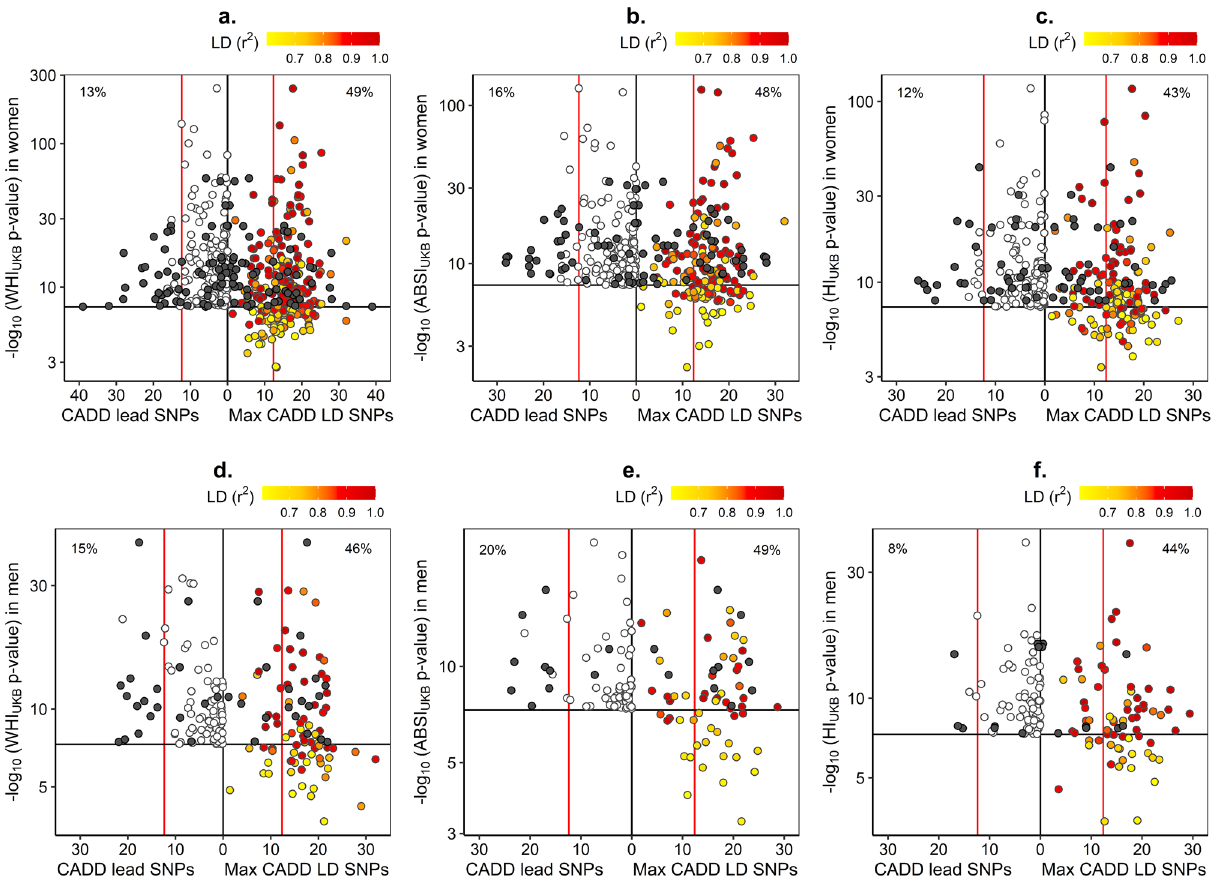
Figure 2. Deleteriousness (CADD) score of locus lead SNPs identified for allometric body-shape indices. ( a ) waist-to-hip index (WHI UKB ) calibrated for UK Biobank women (n = 282 genomic risk loci with the corresponding locus lead SNPs); ( b ) a body shape index (ABSI UKB ) calibrated for UK Biobank women (n = 200); ( c ) hip index (HI UKB ) calibrated for UK Biobank women (n = 171); ( d ) WHI UKB for UK Biobank men (n = 97); ( e ) ABSI UKB for UK Biobank men (n = 65); ( f ) HI UKB for UK Biobank men (n = 75). CADD-Combined Annotation Dependent Depletion; LD-linkage disequilibrium; SNP-single nucleotide polymorphism; red vertical lines-recommended cut-off 12.37 for CADD (the higher the more deleterious) 12 ; horizontal line- genome-wide significance cut-off ( P = 5*10 –8 ); left-hand side-CADD for the locus lead SNP of each genomic risk locus, with the proportion above the cut-off; right-hand side-candidate SNPs in strong LD with the locus lead SNP (colour-coded according to r 2 ≥ 0.6), showing the maximum CADD within the LD block, plotted with the corresponding significance on the y-axis; P WHI / ABSI / HI - P -values for body-shape indices, derived from BOLT- LMM infinitesimal models; (black circle)-marks the locus lead SNP when this is showing the maximum CADD within the corresponding LD block; percentages (top corners)-percentage above the cut-offs for both, CADD and genome-wide significance (all differences between left-hand side and right-hand side proportions were significant at P < 0.0001 when compared with Fisher’s exact test, except for ABSI UKB in men ( P = Fig. S7, Supplementary Fig. S8), except for WC adj BMI and ABSI UKB in women, which showed more similarity (Fig. 6b). The main differences between WC adj BMI and ABSI UKB (Fig. 6b,e) and between HC adj BMI and HI UKB (Fig. 6c,f) concerned independent variants which were either previously reported in association with height or were in strong LD with variants reported in association with height (Supplementary Fig. S9, Supplementary Fig. S10). Half or more of the locus lead SNPs for WC adj BMI in men and for HC adj BMI in men and women had previously been associated with height, compared to less than one third for ABSI UKB and HI UKB (Table 1). More comparable proportions of lead genes (with gene-level significance) had previously been reported in association with height (less than half for allometric indices, Supplementary Fig. S11, and more than half for traditional indices), but the absolute number of lead genes identified for traditional indices was considerably larger (Table 1).